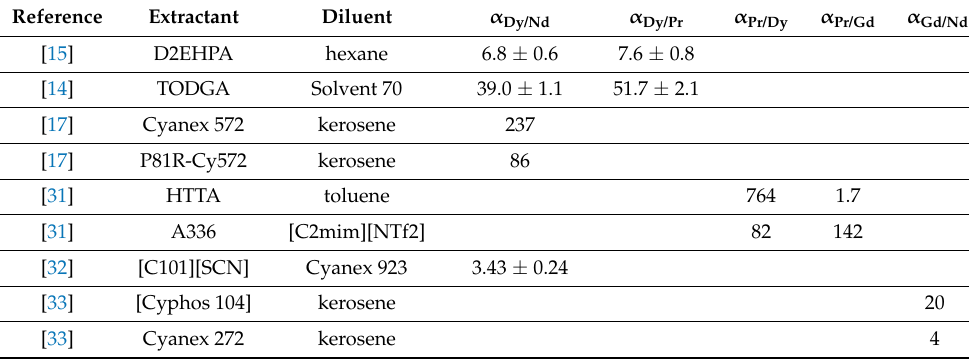
Table 1. The comparison of separation factors of REEs by some